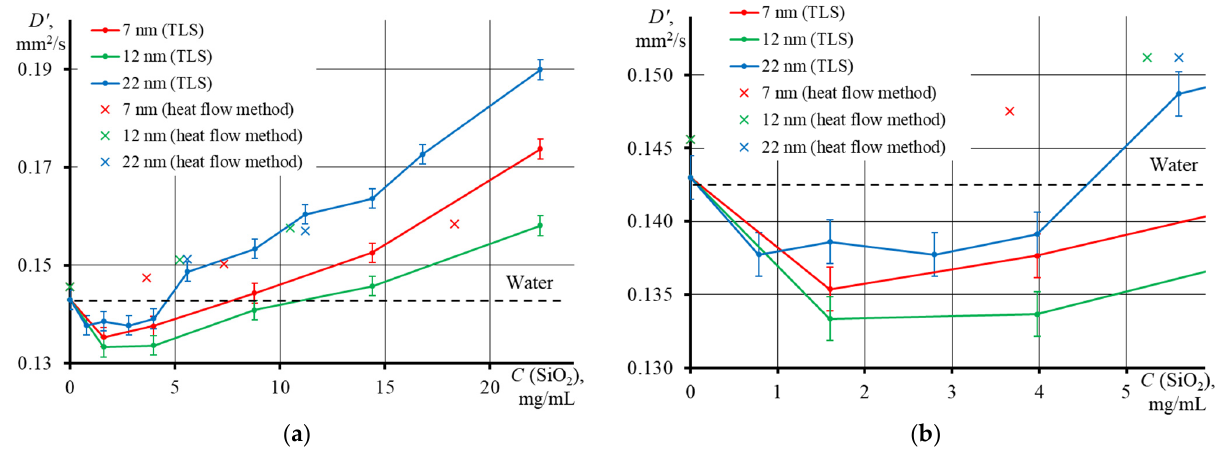
Figure 9. Thermal diffusivity of dispersions of various Ludox series (SM, d av = 7 nm; HS, d av = 12 nm; TM, d av = 22 nm) where: ( a ) in the concentration range from 0 to 22.4 mg/mL, ( b ) up to 5 mg/mL ( n = 5, p = 0.95). The crosses are measurements by the heat flow method, Equation (14), and the lines are measurements by thermal lens spectrometry, Equations (10) and (2).